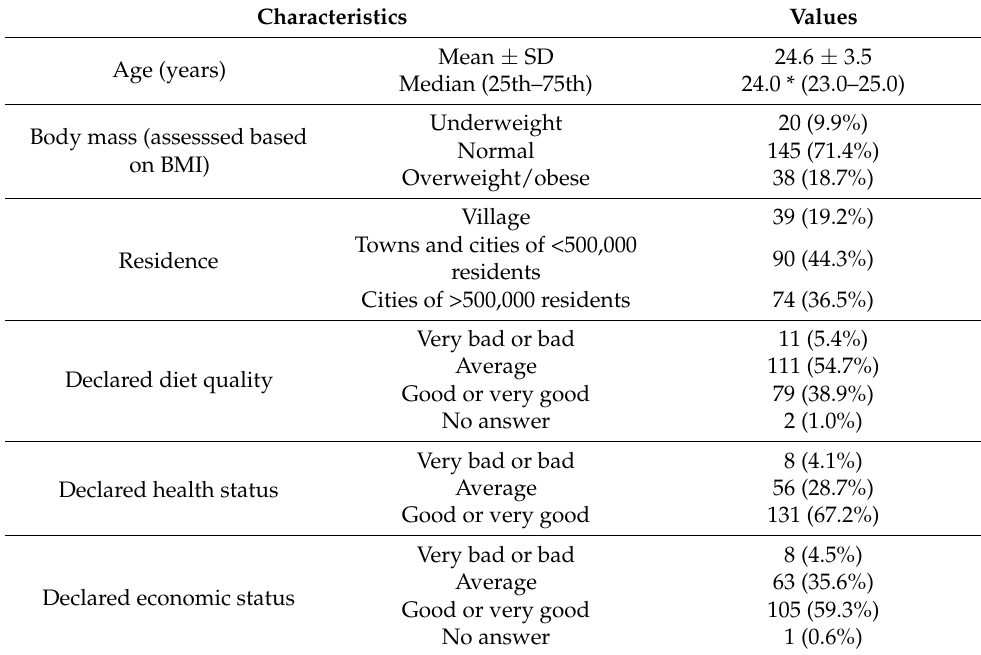
Table 2. The general characteristics of the studied sample of young Polish